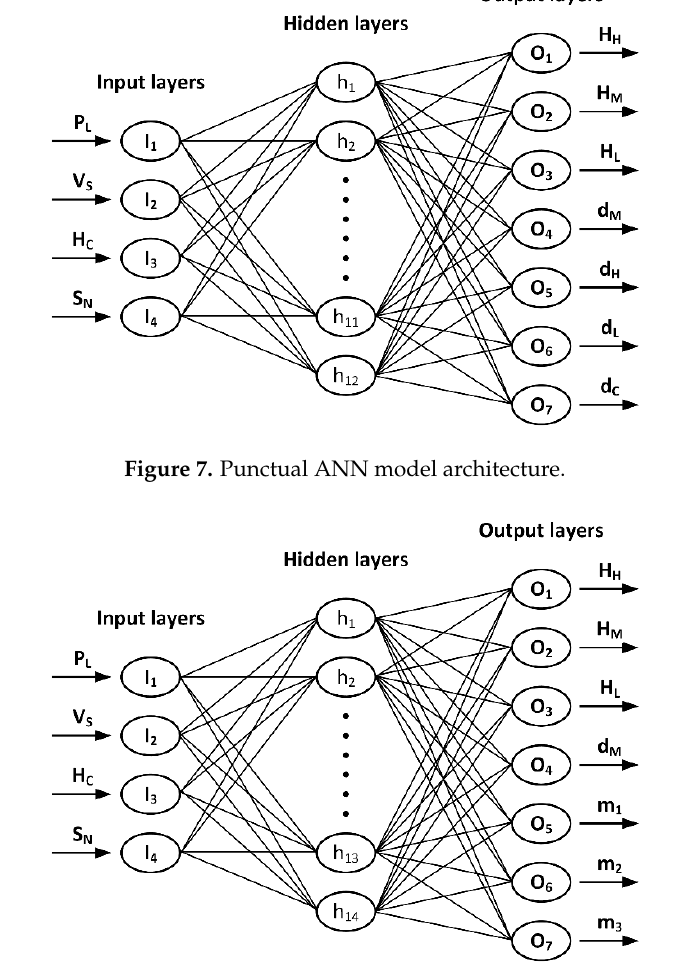
Figure 8. Geometrical ANN model architecture.